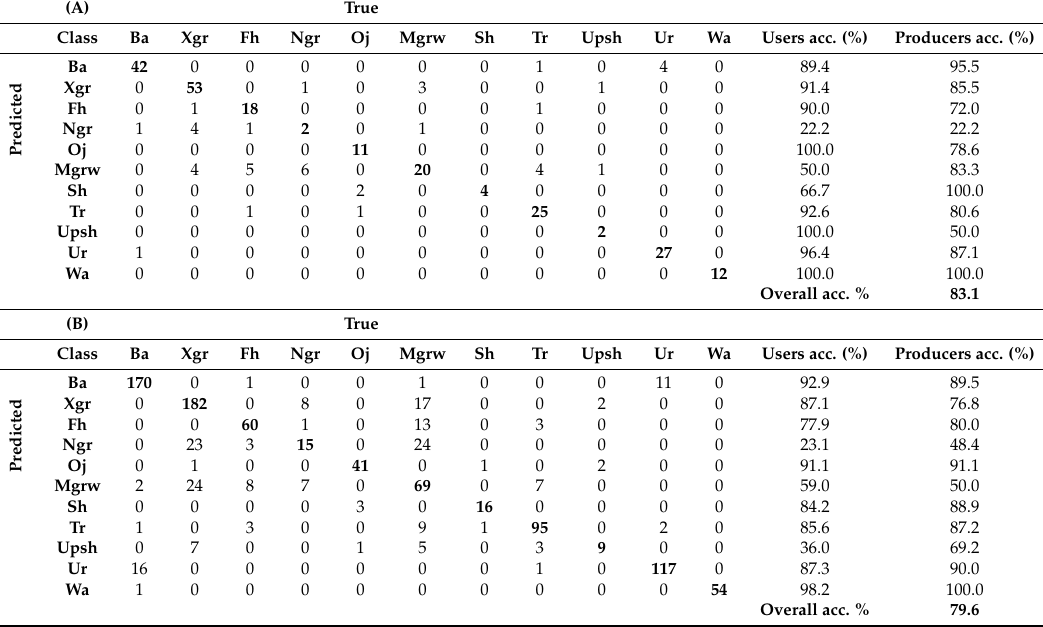
Table 5. Classification error matrices from ( A ) separate testing and training sample data and ( B ) all data bootstrapped error assessment using data left ‘out of bag’ (OOB) at each Random Forest classification model